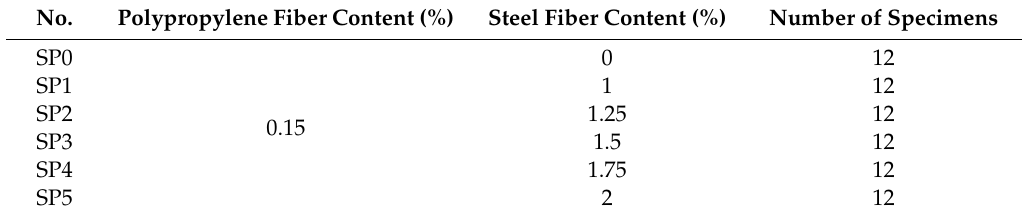
Table 9. Hybrid polypropylene-steel fiber RPC mix